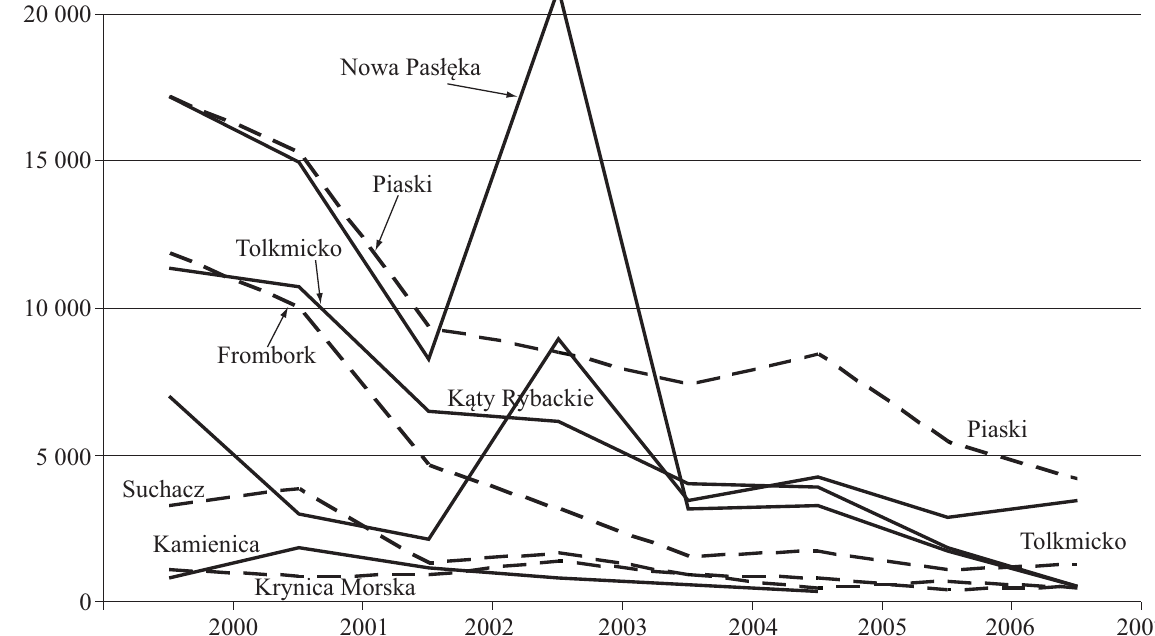
Fig. 2. Eel landings from the Vistula Lagoon fishery bases in the 2000–2007